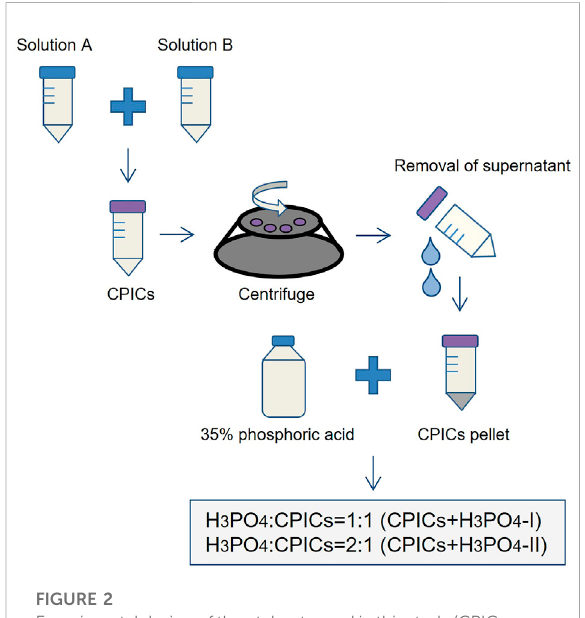
FIGURE 2 Experimentaldesignoftheetchantsusedinthisstudy(CPICs, calcium phosphate ion clusters; H 3 PO 4 , phosphoric